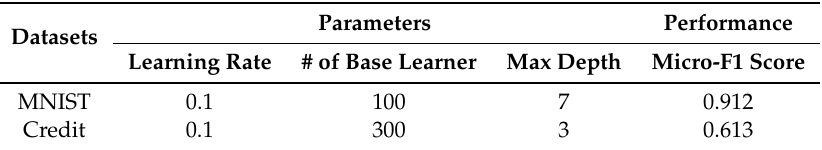
Table 1. The parameters of the GBDT